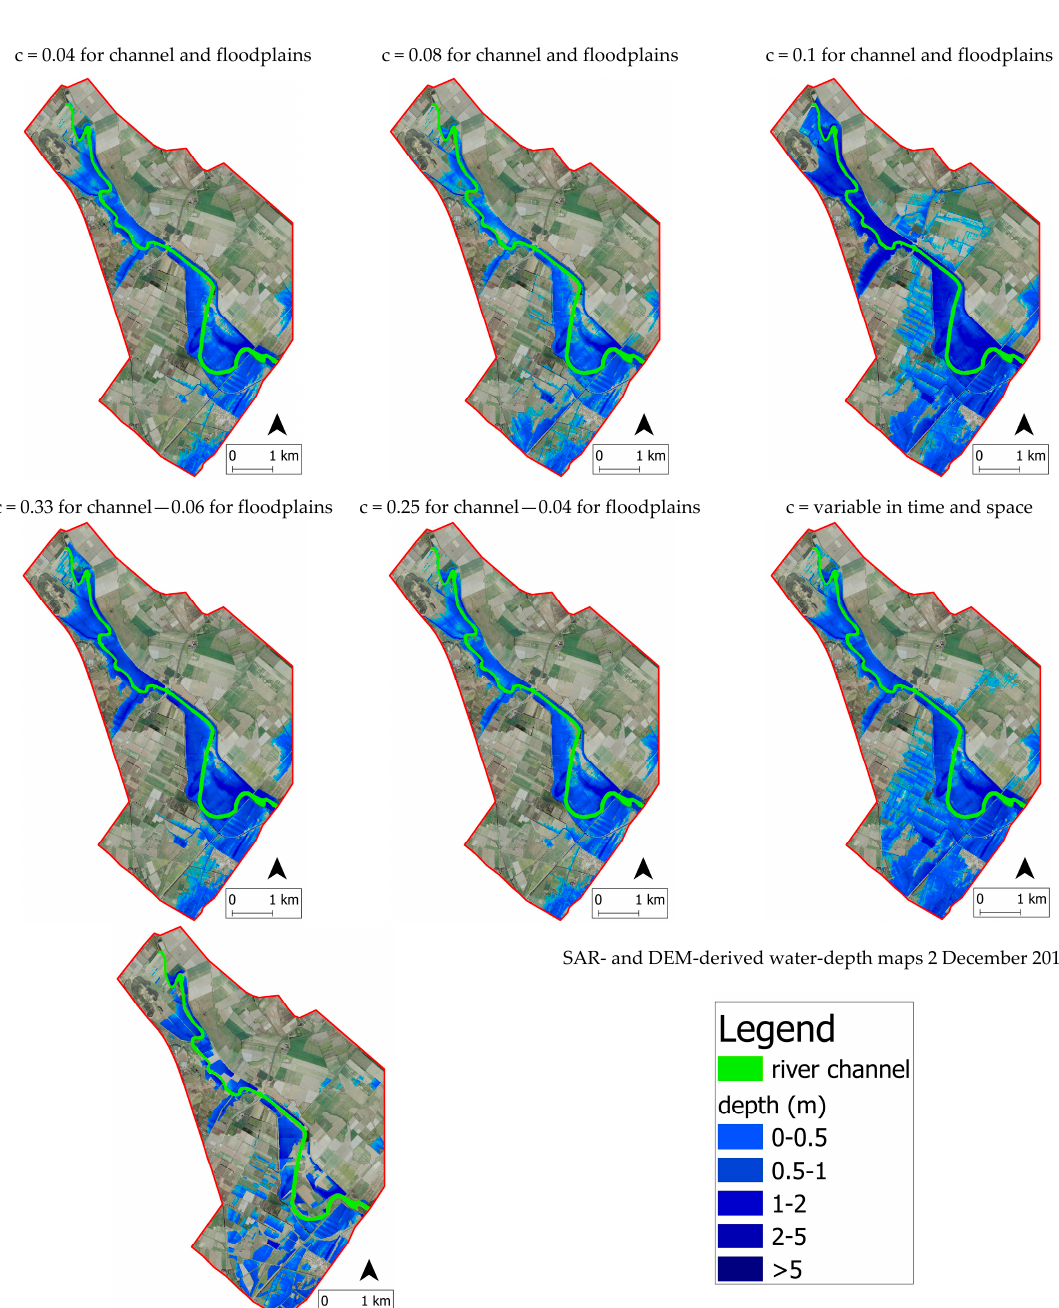
Figure 6. Comparison between the 6 hydrodynamic simulations characterized by a different set of Manning coefficient values and the SAR- and DEM-derived water depth map for 2 December 2013.